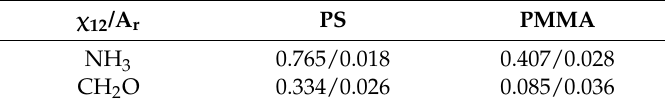
Table 4. Flory-Huggins intermolecular interactions